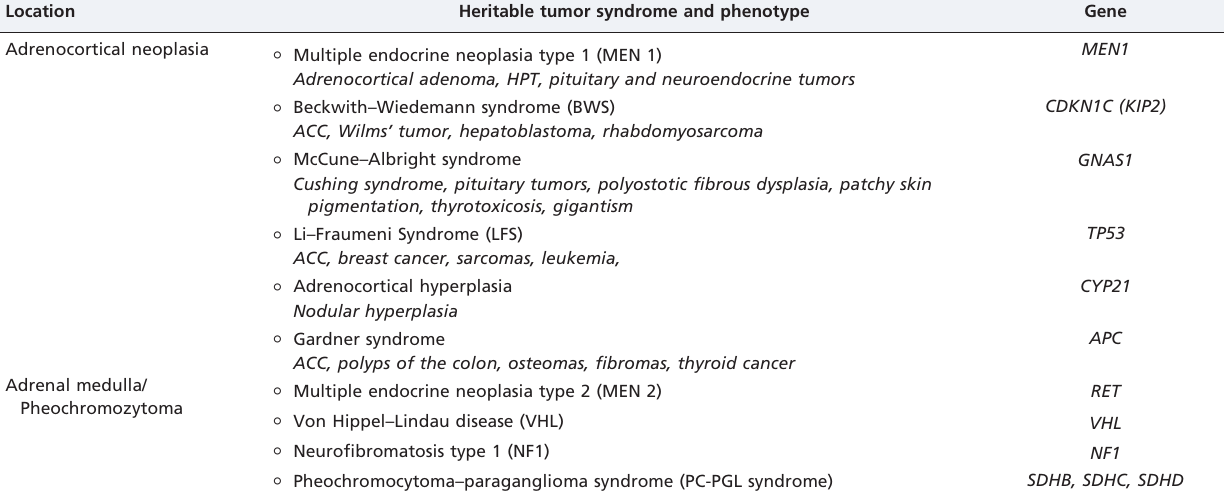
ACC: adrenocortical carcinoma. HPT: